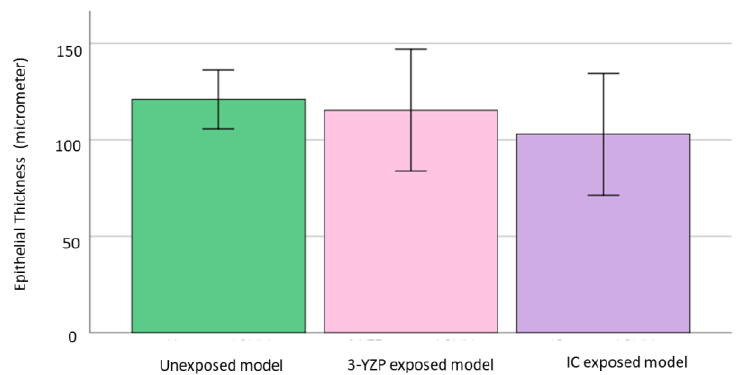
Figure 4. Graph reported on the epithelial thickness of unexposed model, 3-YZP and IC-exposed model. Error bars indicate standard deviation (SD).